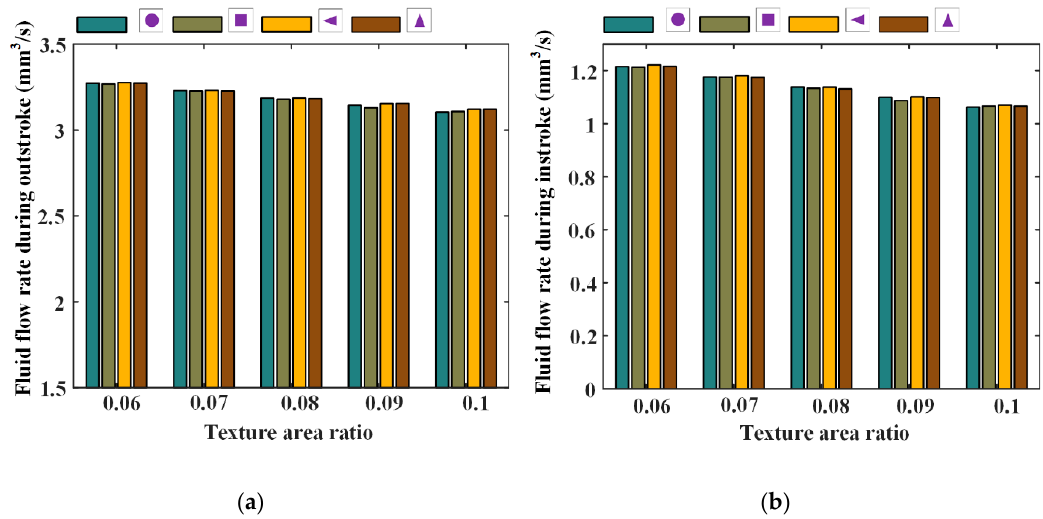
Figure 21. The relationship between wear time rate and texture area ratio, (a) outstroke, (b) instroke.